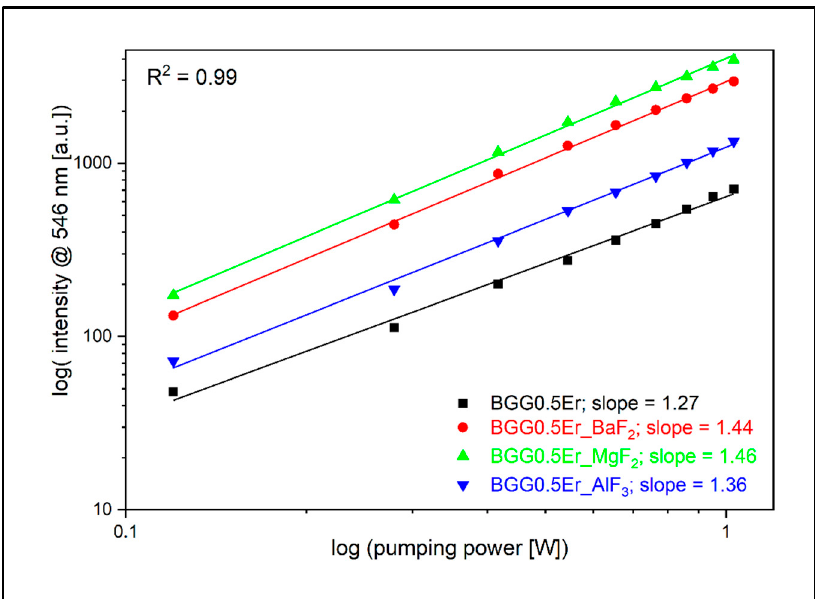
Figure 19. Log–log plot of up-conversion emission at 546 nm of fabricated glasses.